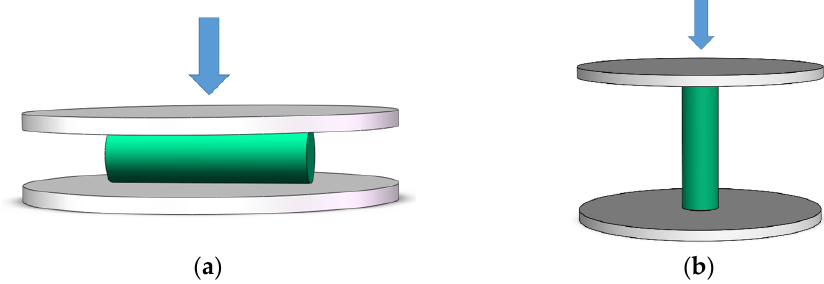
Figure 3. Loading conditions for lithium-ion batteries: ( a ) radial loading; ( b ) axial loading.